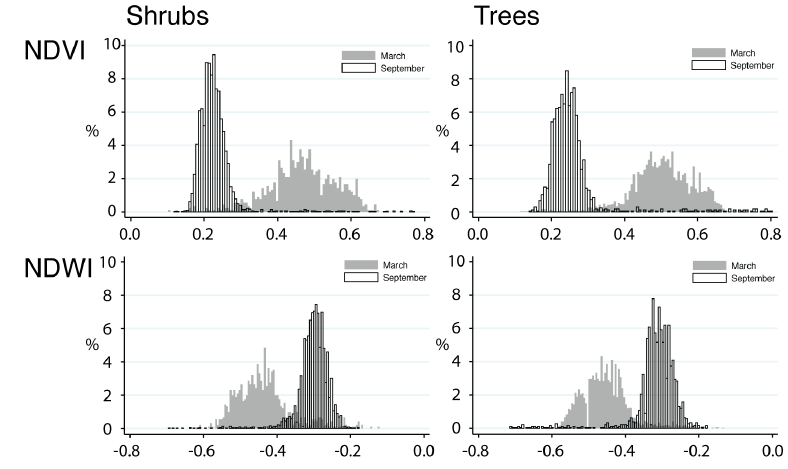
Figure 7. Histograms of Landsat 8 NDVI and NDWI values for trees and shrubs, in March and